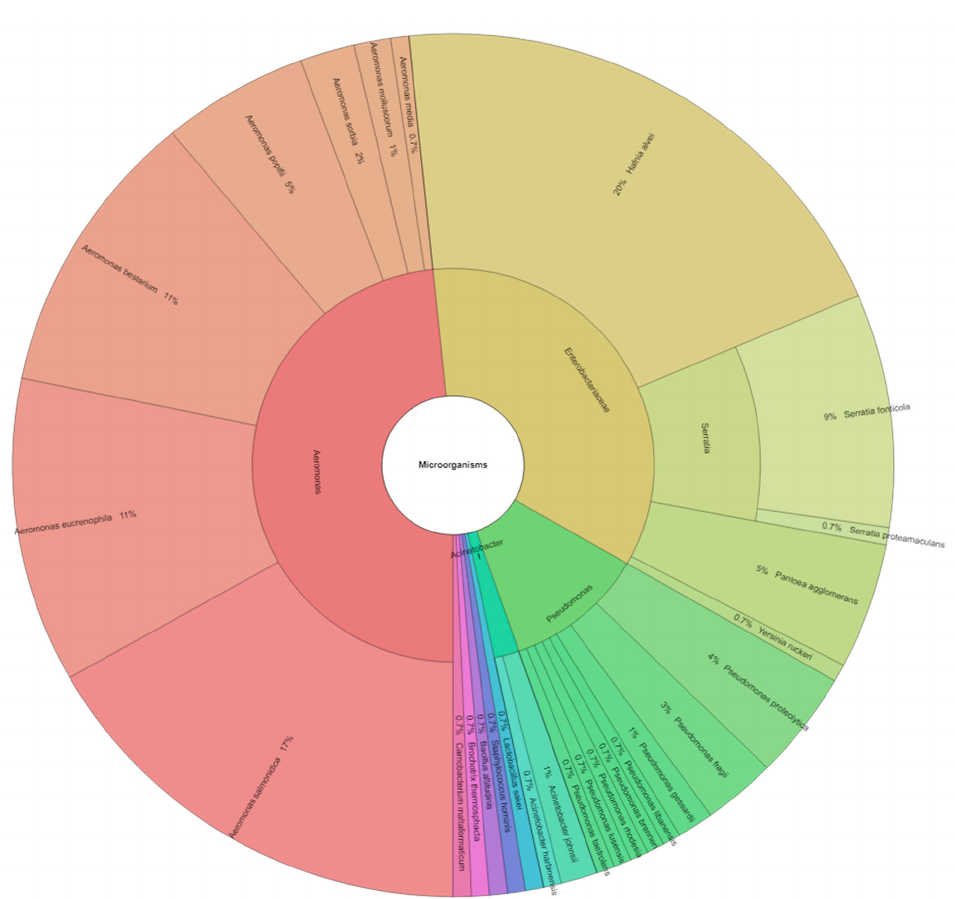
Figure 4. Krona chart of percentage representation of bacterial families .